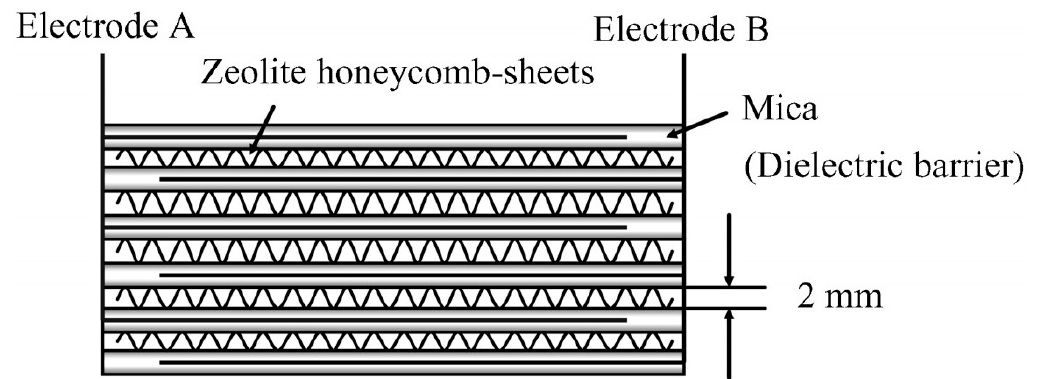
Figure 20. Illustration of the adsorption/plasma combined element with insertion of corrugated honeycomb sheets between discharge electrodes. Reprinted from Reference [37], with permission from Elsevier.